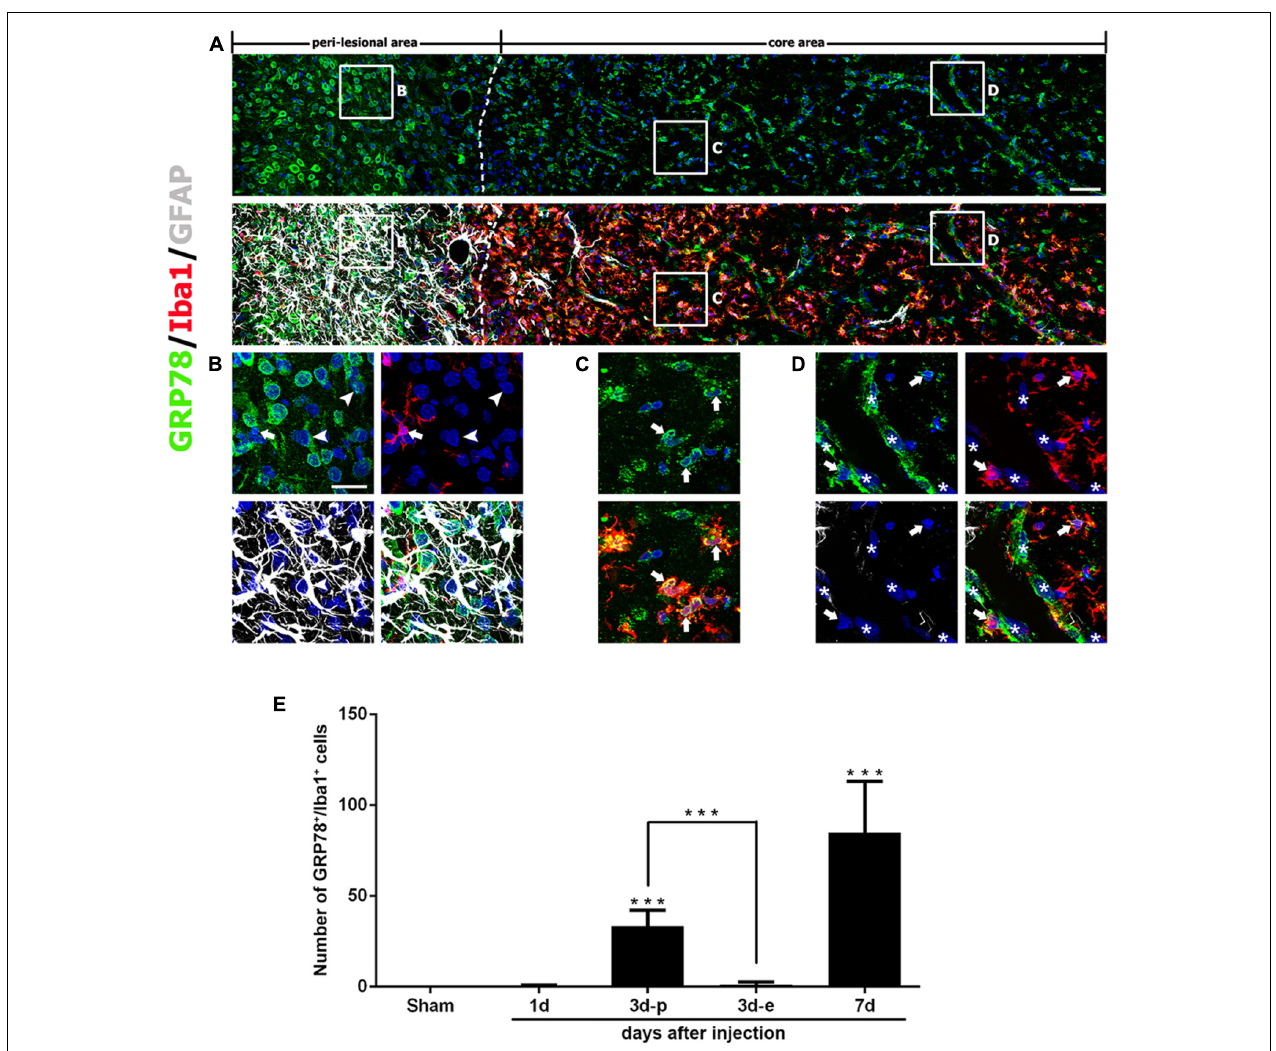
FIGURE 4 | Characterization of glucose-regulated protein (GRP78)-positive cells in lesioned striatum on day 7 after 3-nitropropionic acid injection. (A) Triple-labeling of GRP78, Iba1, and GFAP showing that the lesion core (right side of the broken line) is devoid of GFAP immunoreactivity, but is evenly filled with Iba1-positive cells, nearly all of which express GRP78. The boxed areas in the peri-lesional area and the lesion core are enlarged in the corresponding panels B–D . (B) In the peri-lesional area, evident GRP78 immunoreactivity is observed in reactive astrocytes (arrowheads) and activated microglia (arrows). (C,D) In the lesion core, intense GRP78 expression is observed in the vascular profiles (asterisks) and in activated microglia/macrophages (arrows). (E) Quantitative temporal analysis showing that the number of GRP78-positive microglia/macrophages increases progressively over a 7-day period after lesion induction. Note that the number of GRP78-positive microglia/macrophages is significantly higher in the lesion periphery than in the epicenter on day 3. The data are expressed as the mean ± standard error of the mean. ∗∗∗ P < 0.001 vs. saline-treated controls. Cell nuclei are stained with 4 (cid:48) ,6-diamidino-2-phenylindole. Scale bars represent 50 µ m for A ; and 20 µ m for B–D